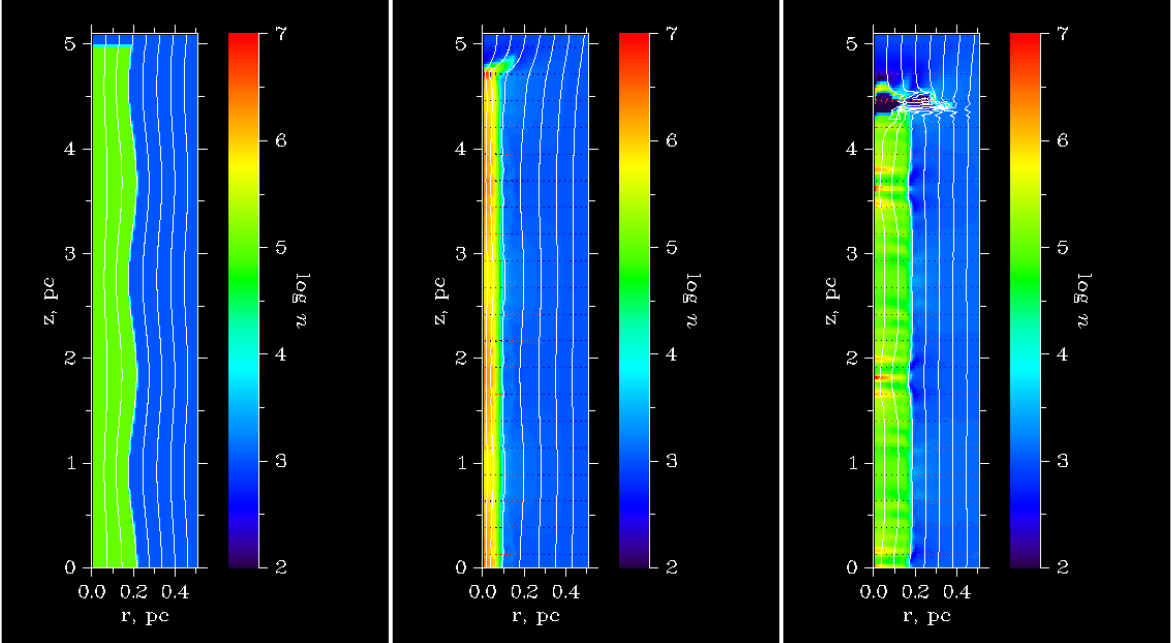
Figure 4. Two-dimensional density (color filling) and magnetic field (white isolines) distributions for the initially perturbed adiabatic cylin- der with magnetic field at t = 0 yrs (initial state, left), t = 1.17 × 10 5 yrs (center), 1.77 × 10 5 yrs (right) after the beginning of the collapse.